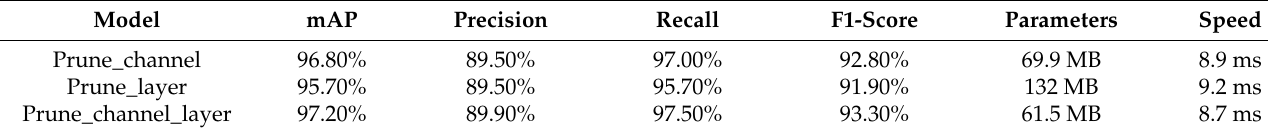
Table 2. Comparison of the results of different levels of pruning.